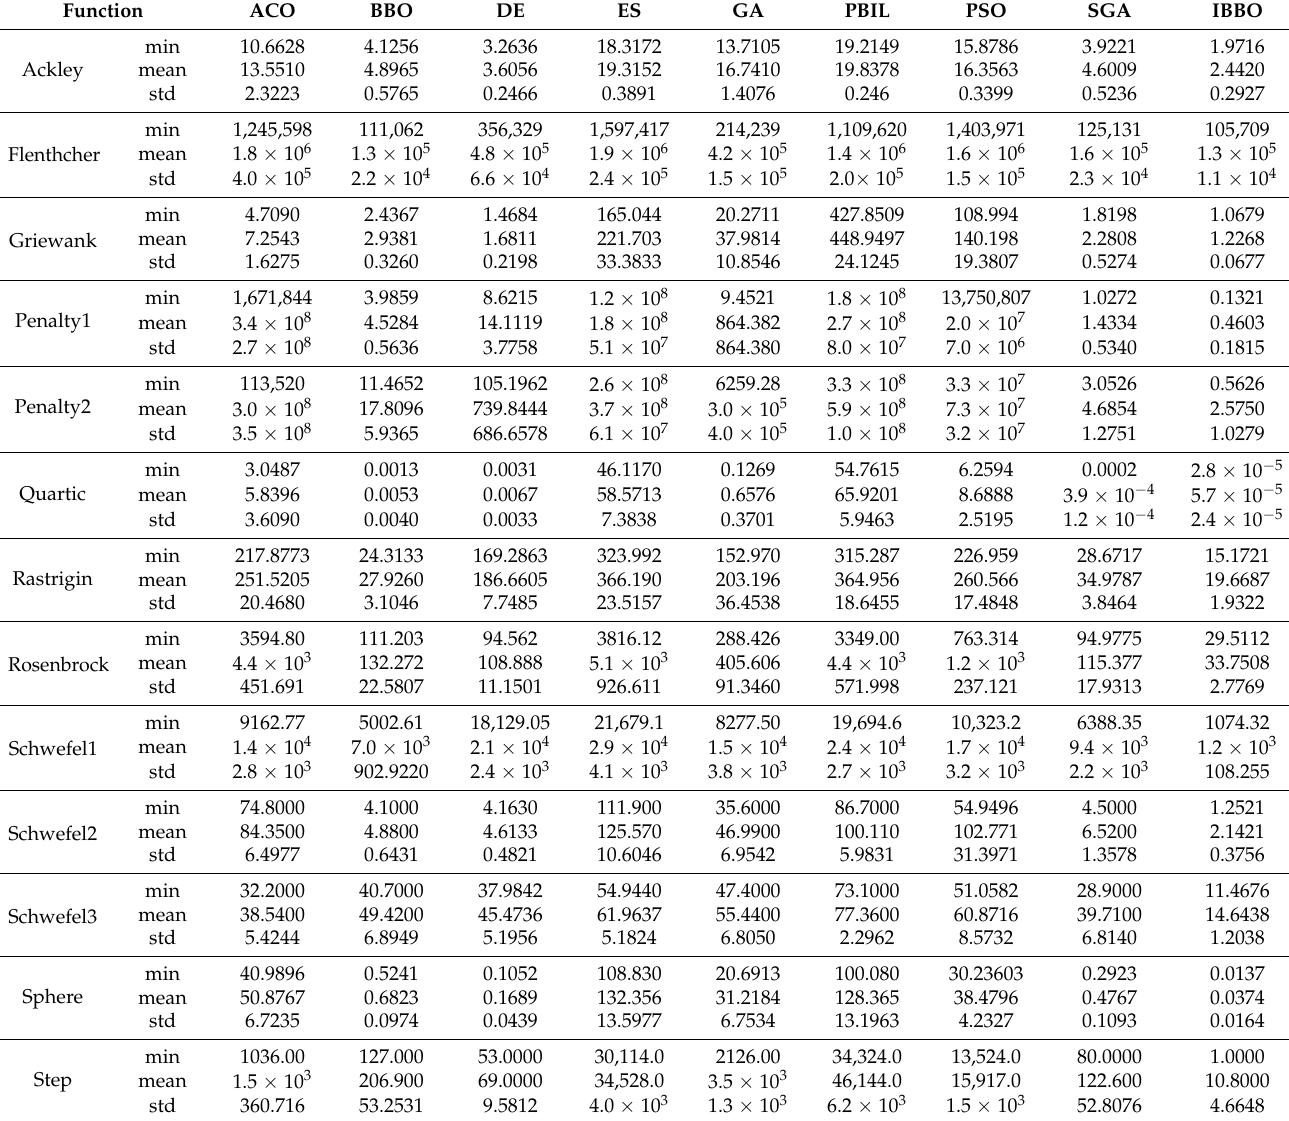
Table 2. Comparison results of nine algorithms for 13 test